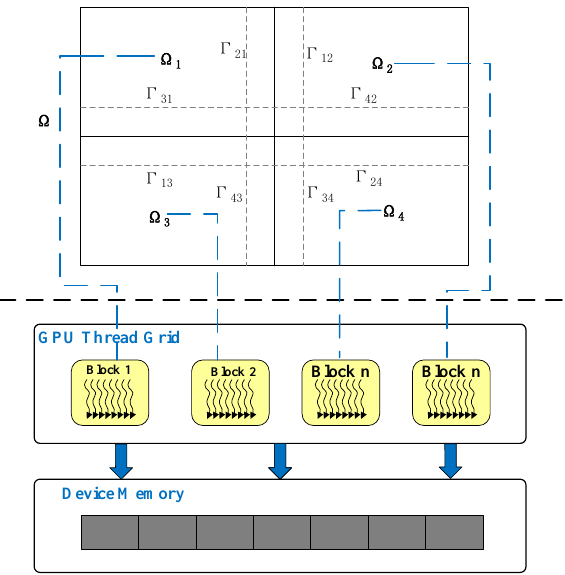
Figure 3. GDDM method